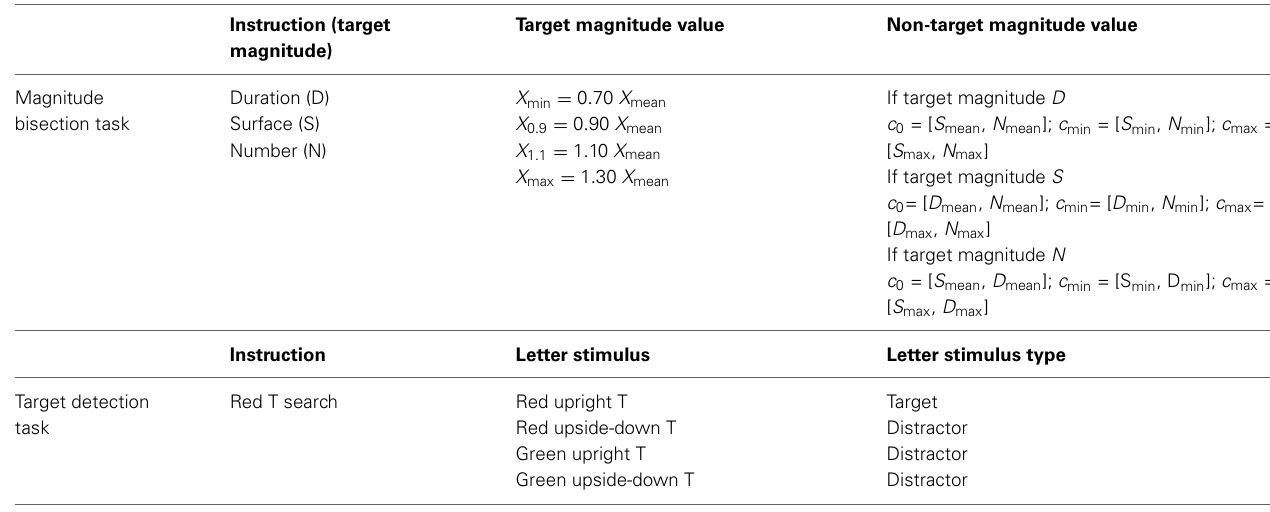
Table 2 | Experimental design for Study